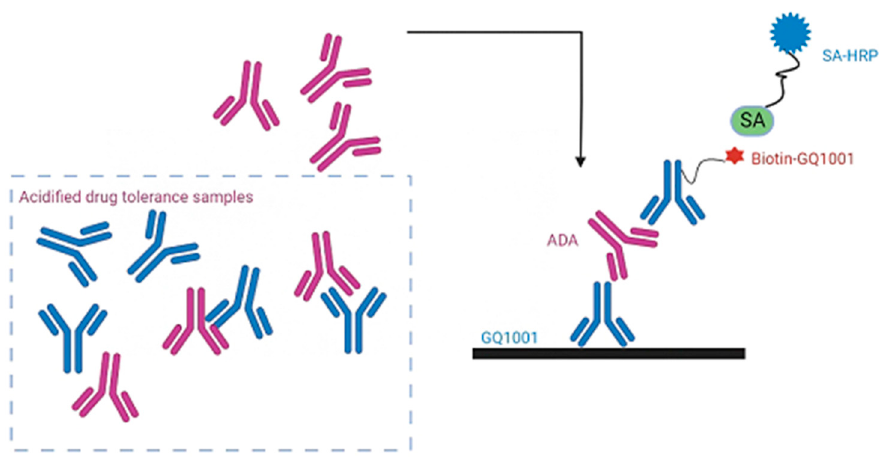
Figure 4. Principle of the acid-dissociation bridging ELISA. An acid-dissociation step at pH of 2.2 is first conducted to render antibodies in a sample free of drug and then ready to re-bind to either free drug or immobilized drug after neutralization of pH. The bridging part of the assay is configured with GQ1001 for capturing ADAs, and biotinylated GQ1001 plus later-added HRP-labeled streptavidin for detecting the bridged ADA-drug